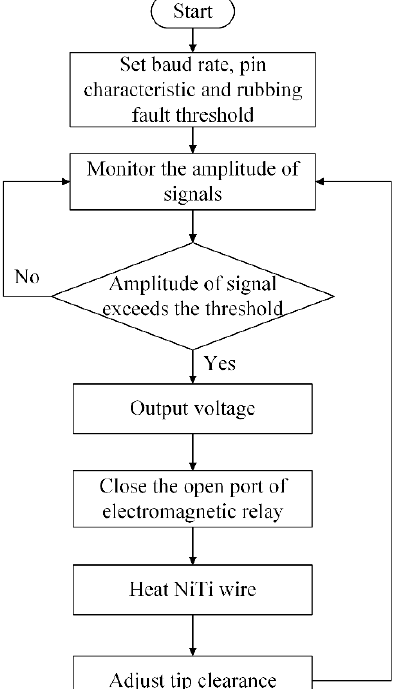
Figure 11. Configuration of the control system.